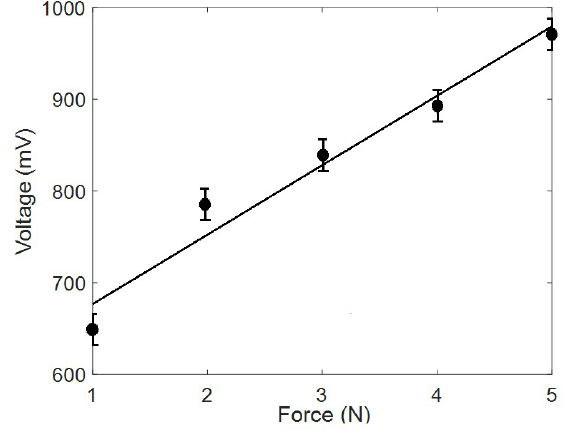
Figure 5. Mean peak-to-peak converted voltage through the electrospun nanofibers under the impact of applied cyclic force.